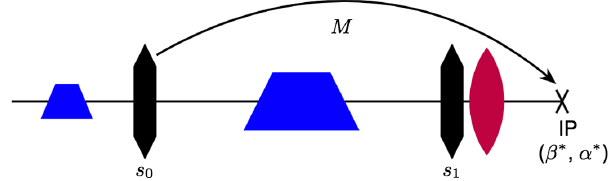
FIG. 2. Layout of a simplified FFS based on the local- chromaticity-correction principle. Quadrupole magnet are shown in red, sextupoles in black, and dipoles in blue. The s 0 and s 1 label the sextupoles ’